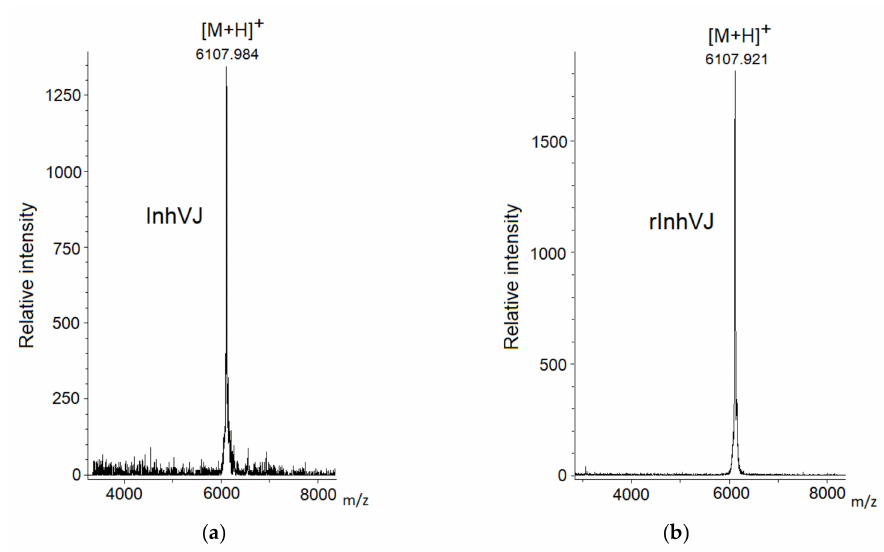
Figure 2. Mass spectra of native InhVJ ( a ) and recombinant InhVJ ( b ) peptides. Table 1. Molecular weighs and inhibition constants of the